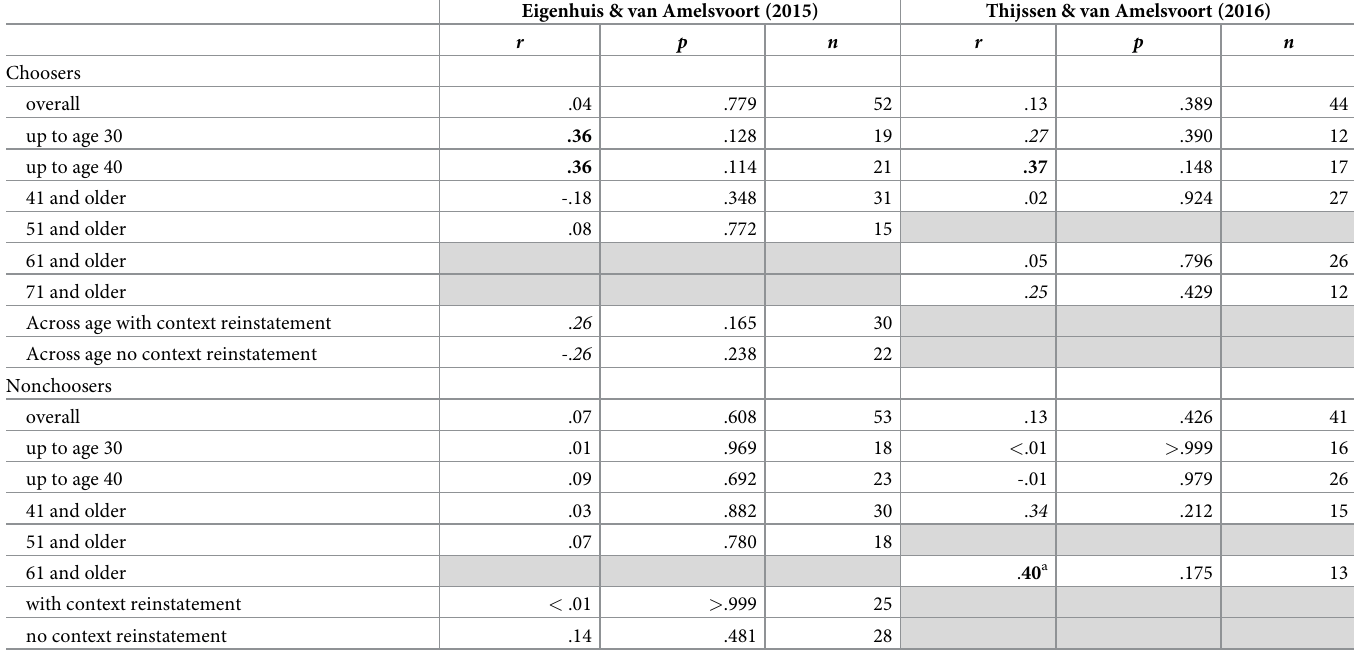
Table 3. Witnesses point-biserial confidence-accuracy correlations with p-values and sample sizes computed split across choosers and nonchoosers for two